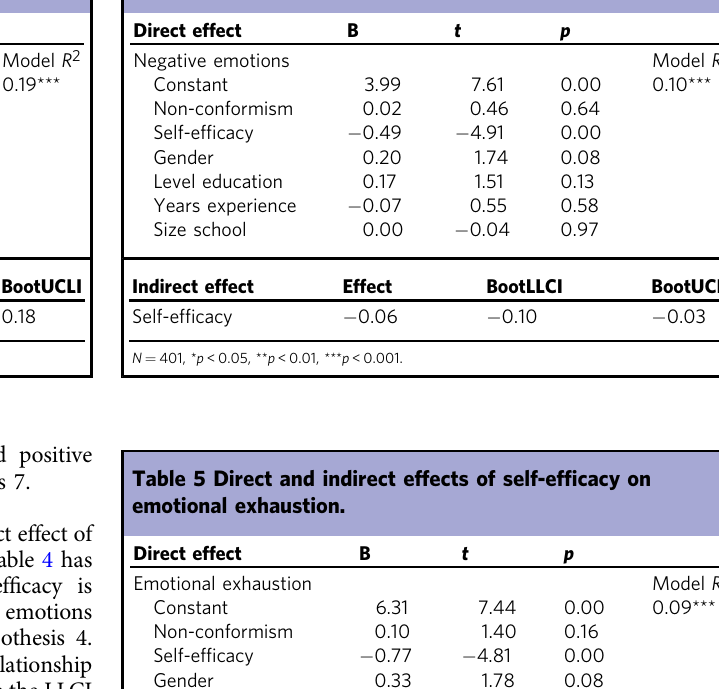
Table 4 Direct and indirect effects of self-ef fi cacy on negative emotions.